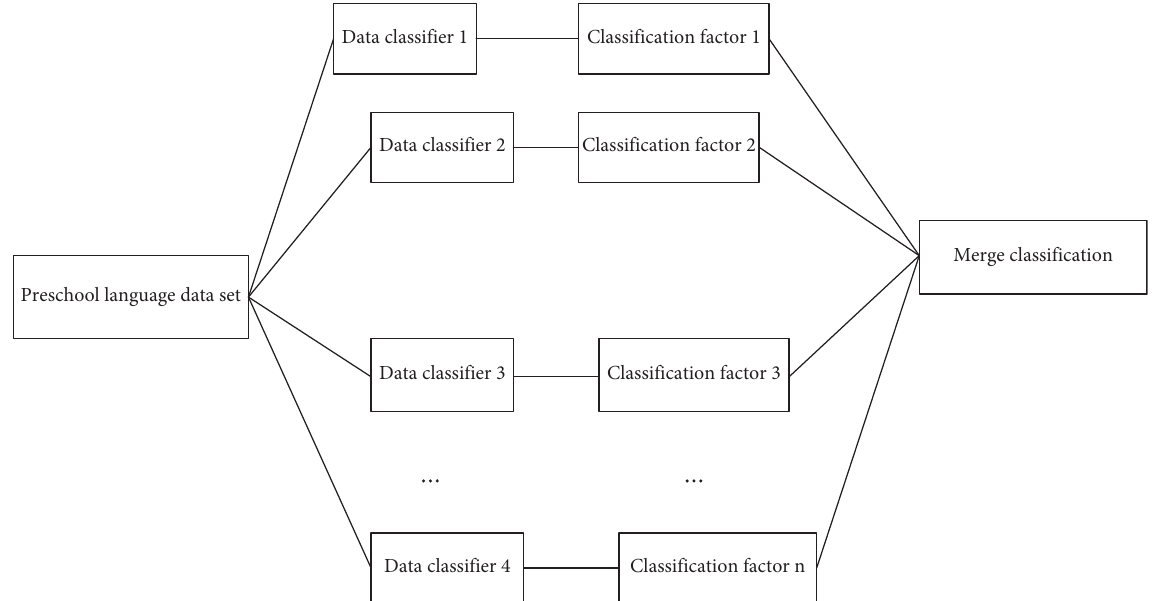
Figure 2: Data classification process of preschool language education